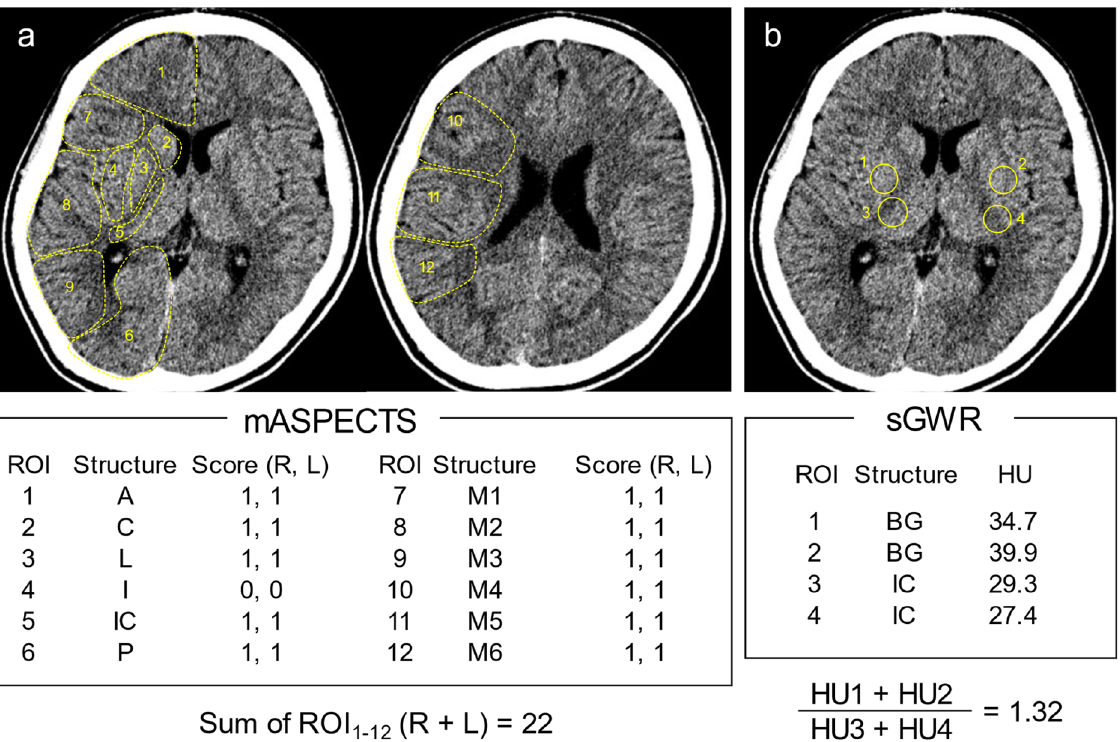
Figure 2. Representative head CT scan in a 13-year-old boy with post-cardiac arrest. ( a ) A schematic presentation of the mASPECTS. Summary of the 24 areas makes the score of 22. ( b ) The formula for calculating the sGWR. Relative HU values of the putamen to those of the posterior limb of the IC equals to 1.32. ROI: region of interest, IC: internal capsule, A: anterior circulation, C: caudate, I: insular ribbon, L: lentiform, M: middle circulation, P: posterior circulation, HU: Hounsfield units, BG: basal ganglia.